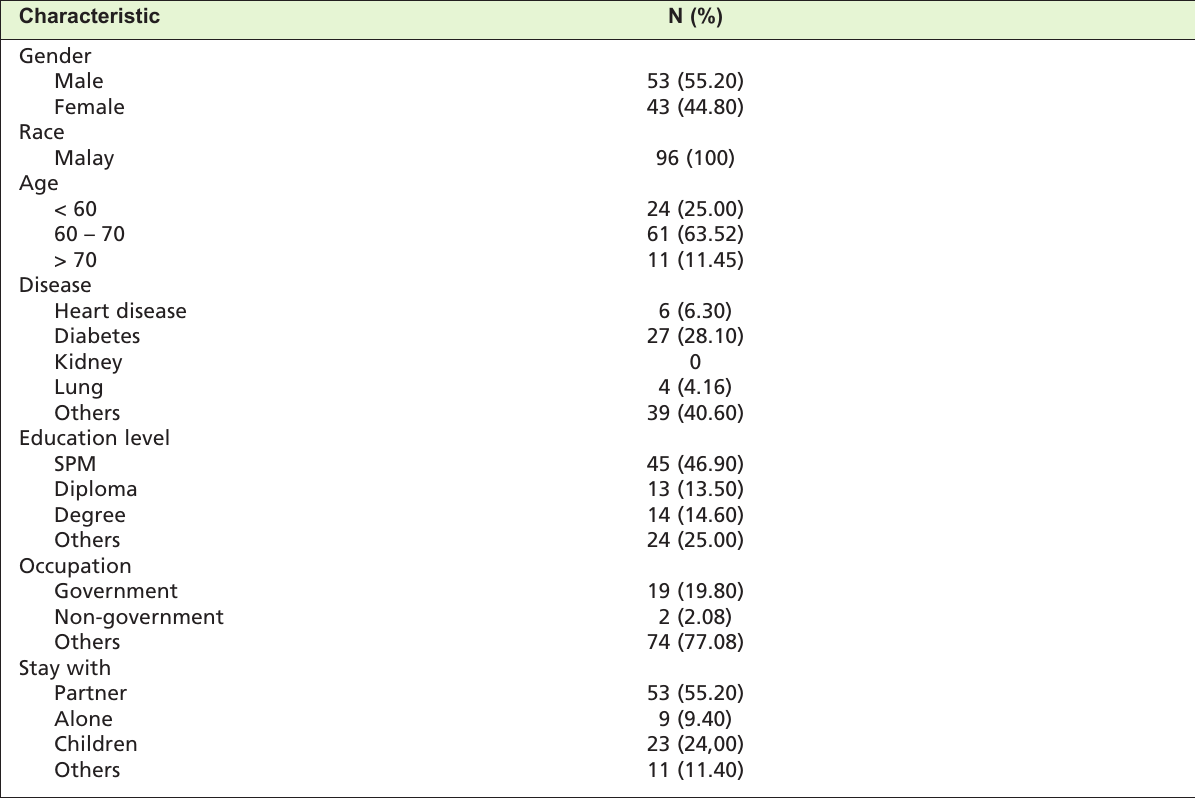
Table II: Socio-demographic characteristics of the respondent in quantitative part (n=96).